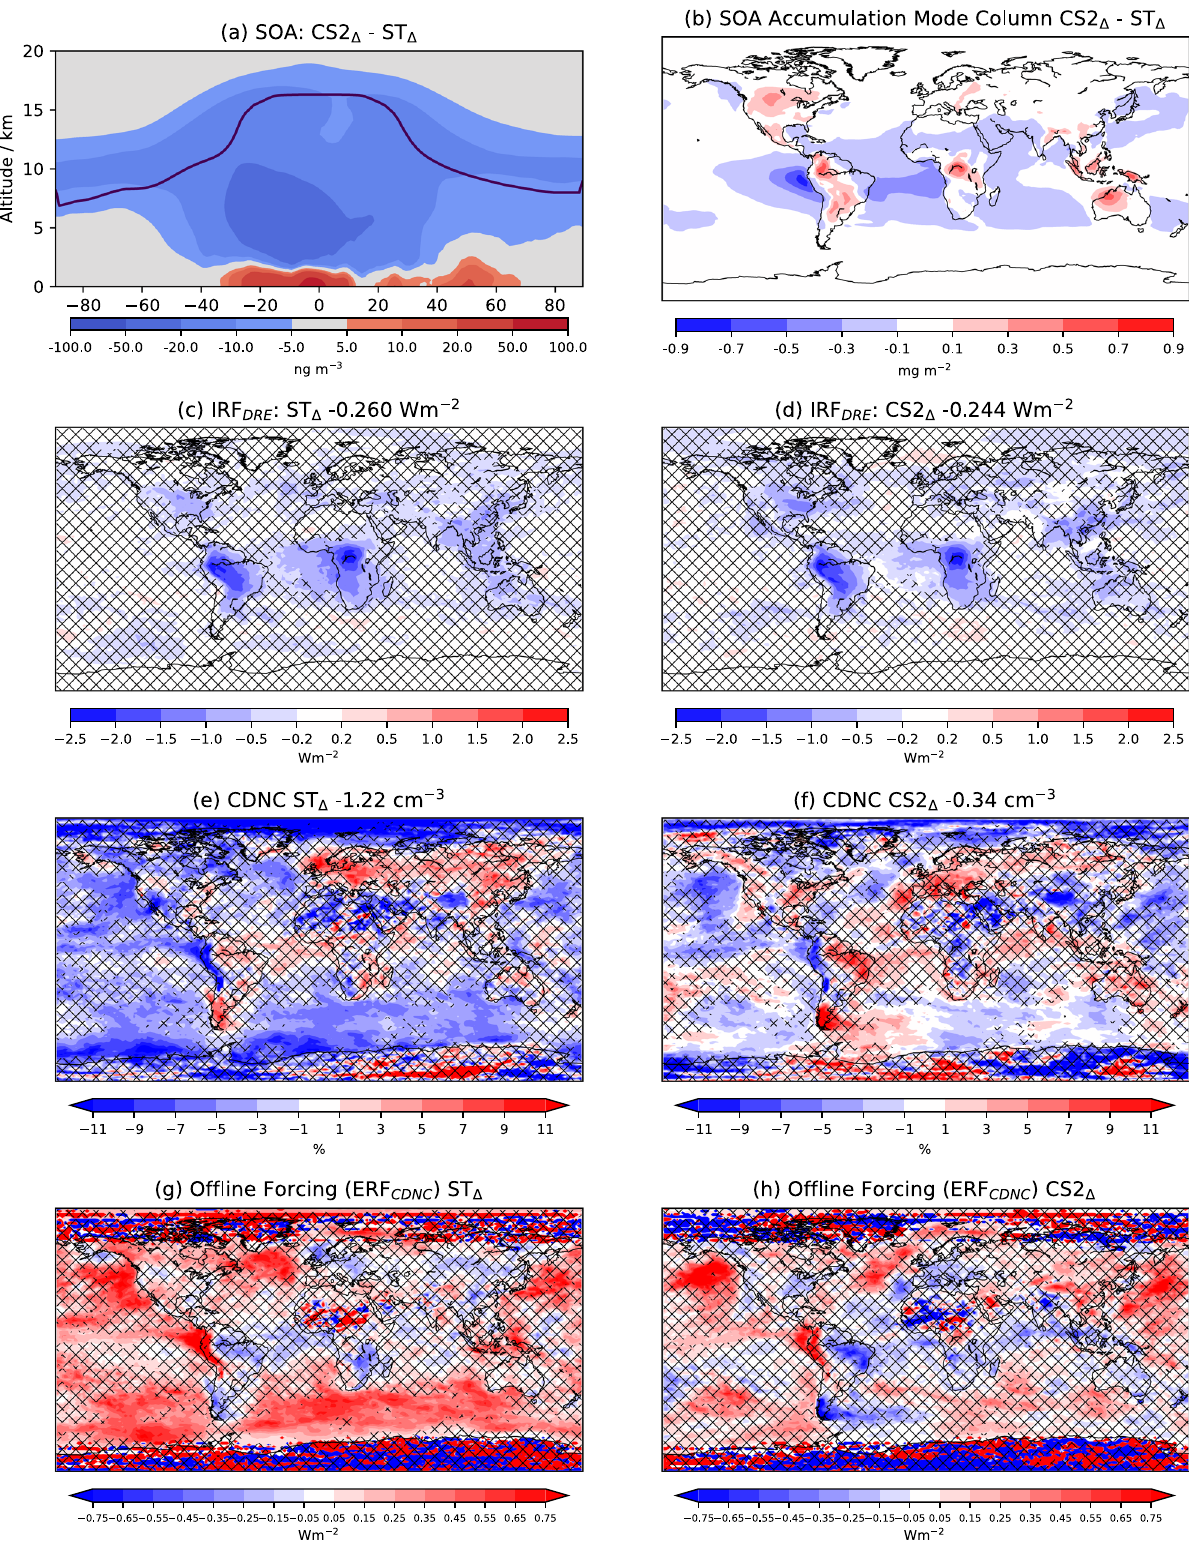
Fig. 4 | Secondary organic aerosol (SOA) changes, aerosol scattering forcing, cloud droplet number concentration changes and associated cloud forcing. Differencein( a )zonalmeanSOAincreaseand( b )accumulationmodeSOAcolumn increase between CRI-Strat 2 (CS2 Δ ) and Strat-Trop (ST Δ ). Radiative forcing from the change in the aerosol direct radiative effect (IRF DRE ) for ( c ) ST Δ and ( d ) CS2 Δ . Percentage change in vertically averaged cloud droplet number concentration